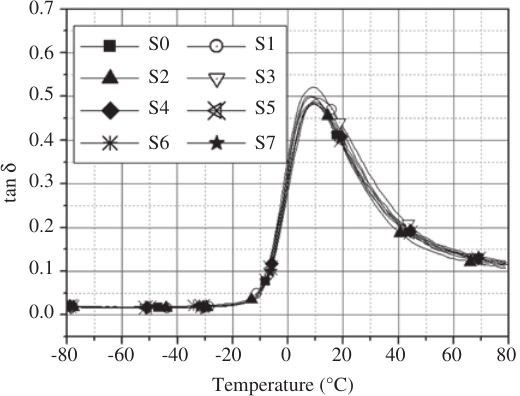
Figure 5 Dynamic mechanical properties: dependence of the mechanical loss angle tangent (tan δ ) on the temperature of the investigated